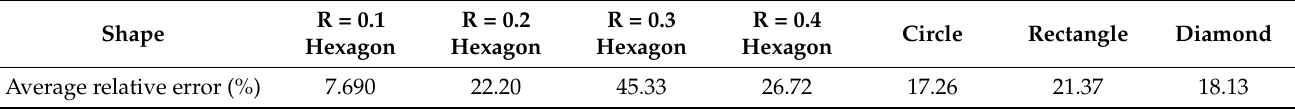
Table 5. Average relative error of predicted drag coefficient after changing